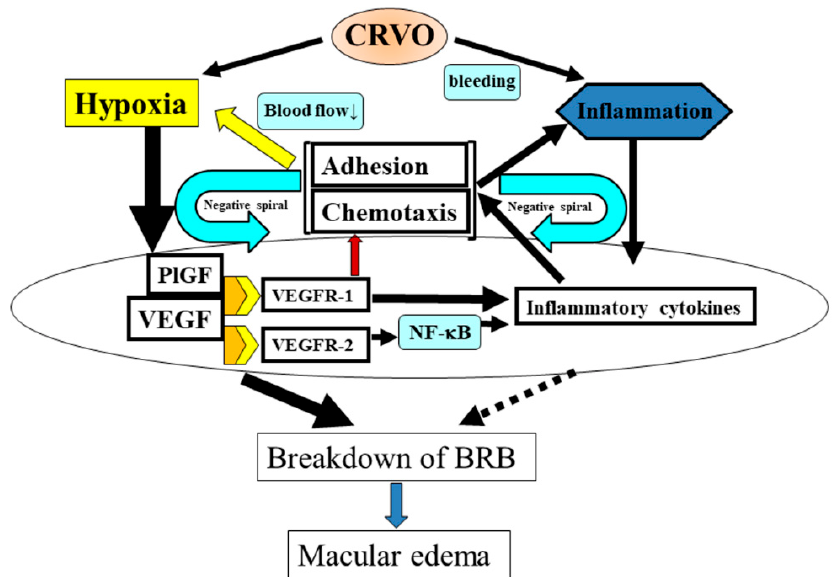
Figure 3. Mechanism of macular edema pathogenesis in central retinal vein occlusion (CRVO). CRVO causes ischemia and produces inflammation that is secondary to impaired retinal perfusion and hemorrhage. This is associated with an upregulation of VEGF and inflammatory cytokine expression, which disrupts the blood–retinal barrier (BRB) and ultimately results in macular edema. VEGF and PlGF activate VEGFR-1, leading to leukocyte recruitment and further increasing inflammatory cytokine expression. In addition, VEGF activates VEGFR-2, which increases vascular permeability and further enhances the expression of inflammatory cytokines such as MCP-1 and ICAM-1 via NF- κ B. The resultant chemotaxis and adhesion of leukocytes to the vascular endothelium decreases blood flow